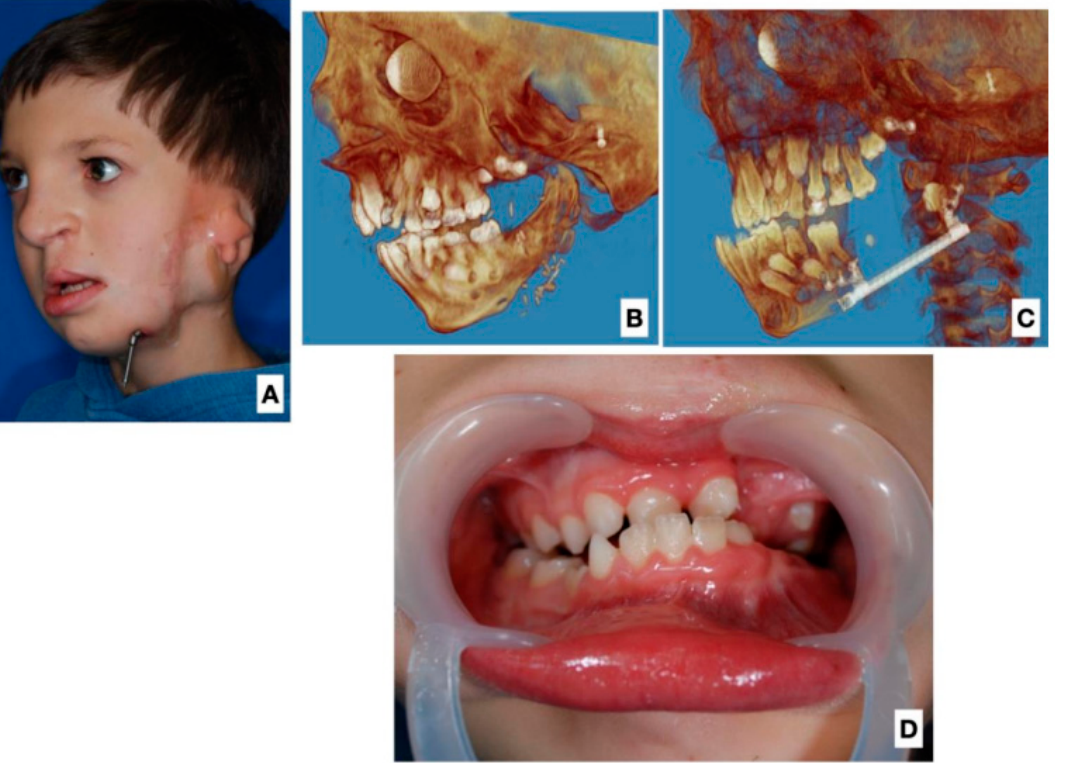
Figure 3. The same patient two years after surgery. ( A ) Three-quarter view after completion of osteodistraction. ( B ) 3D image reconstruction after FFF reconstruction. ( C ) 3D image reconstruction after completion of mandibular distraction. ( D ) Intraoral view with visible overcorrection and dentition set in reverse occlusion.